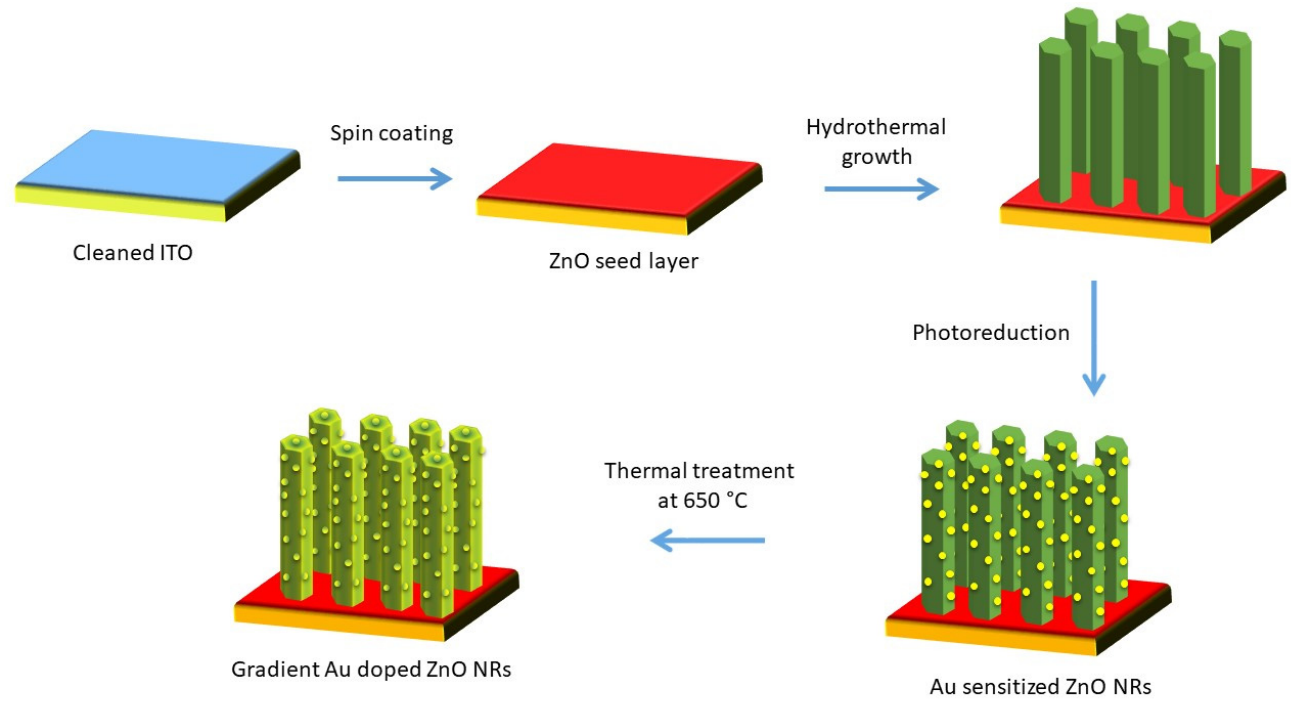
Figure 10. Schematic illustration of fabrication of gradient Au-doped ZnO nanorods.